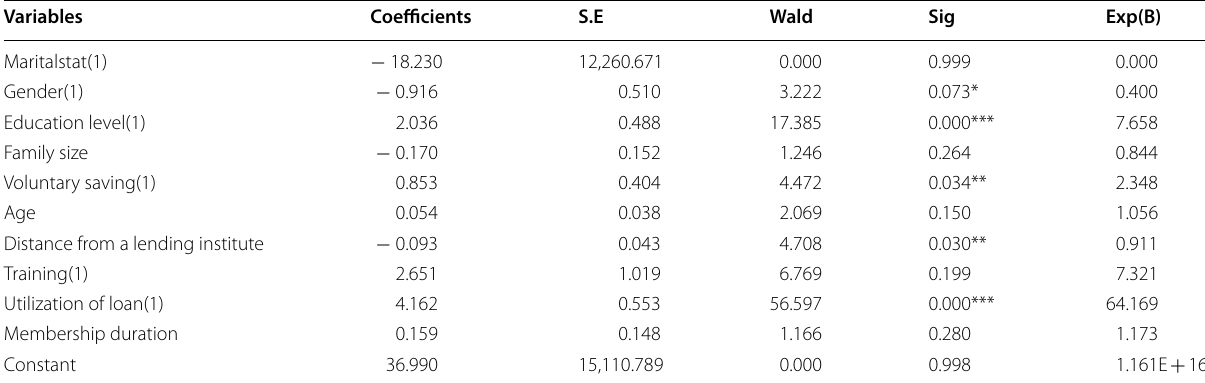
***, **, *indicates that the level of significance at 1%, 5%, and 10%, respectively